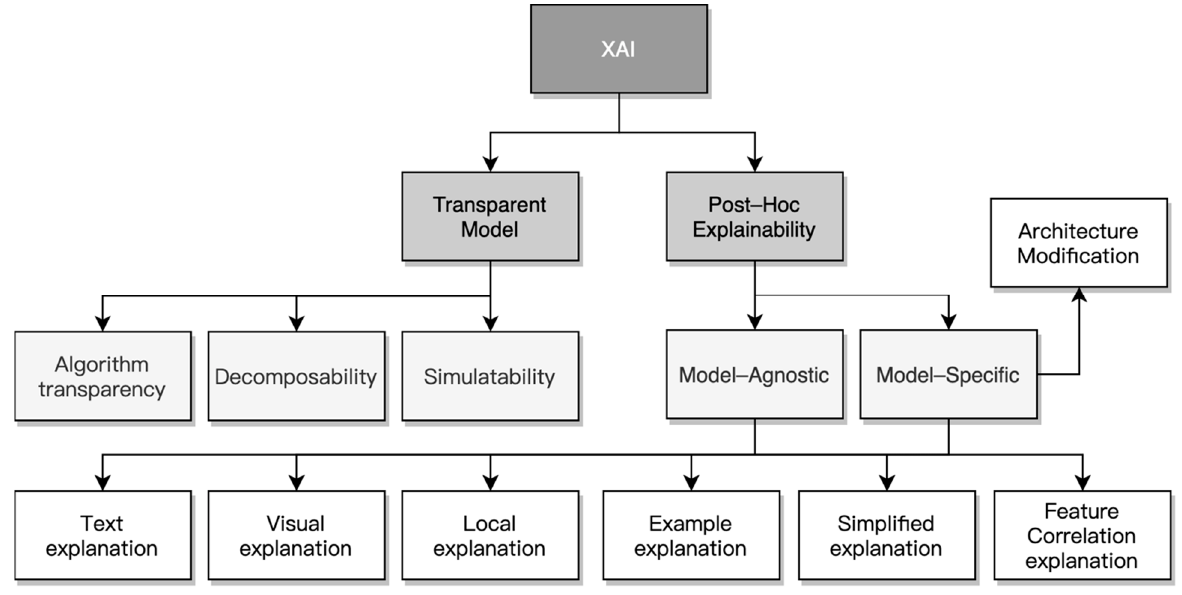
Figure 1. Classication of explainable artifical intellengence methods .